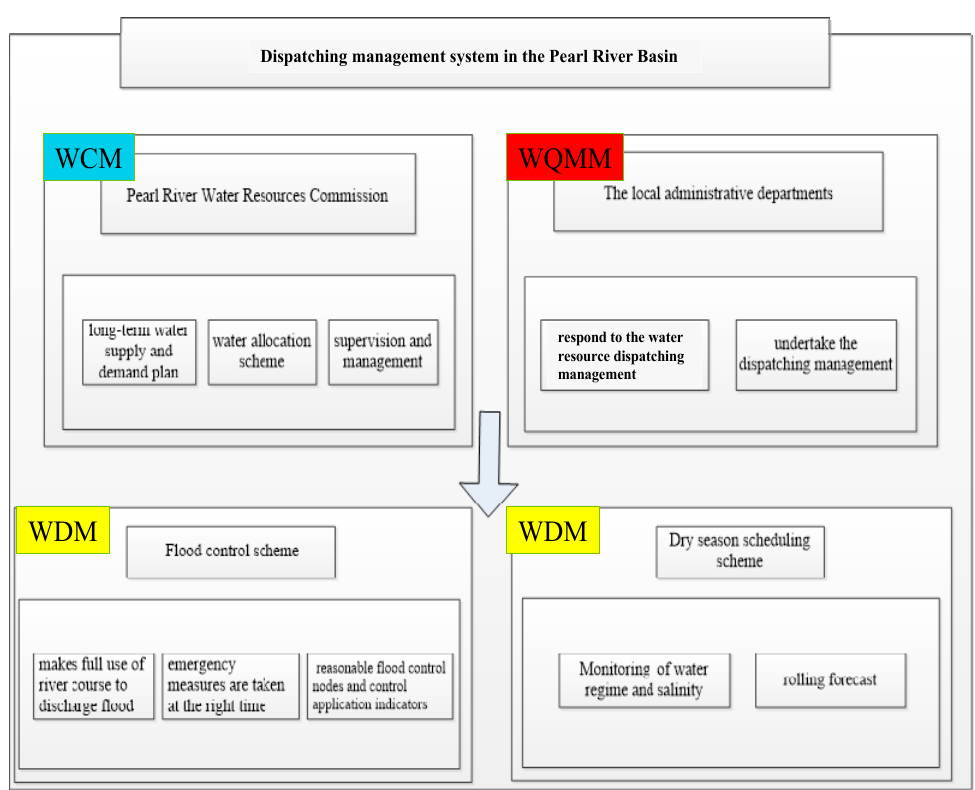
Figure 8. Framework of the dispatching management system for the Pearl River Basin (PRB). Different modules are shown in different colors (blue: WCM module; red: WQMM module; yellow: WDM module). There is no MDFM module owing to the abundance of water in the PRB.